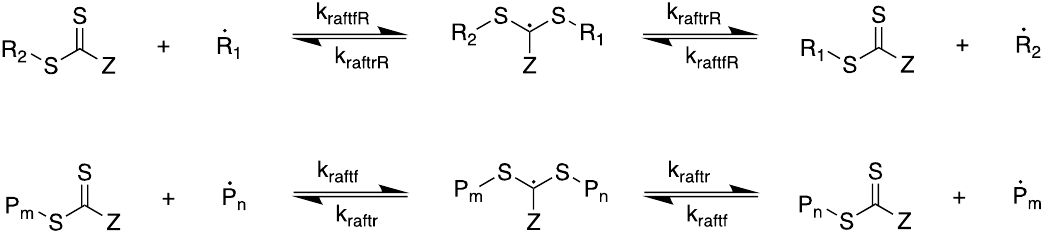
Scheme 1. Kinetic scheme of reactions involving the RAFT